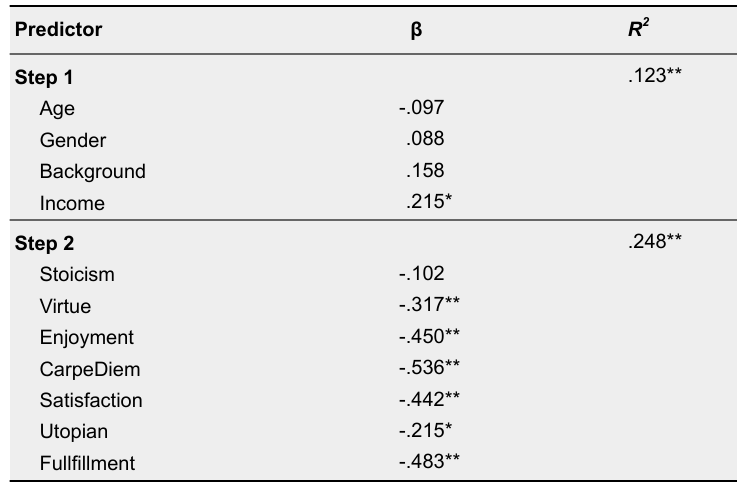
Conceptual Referents Predicting Life Satisfaction After Controlling Socio- Demographic